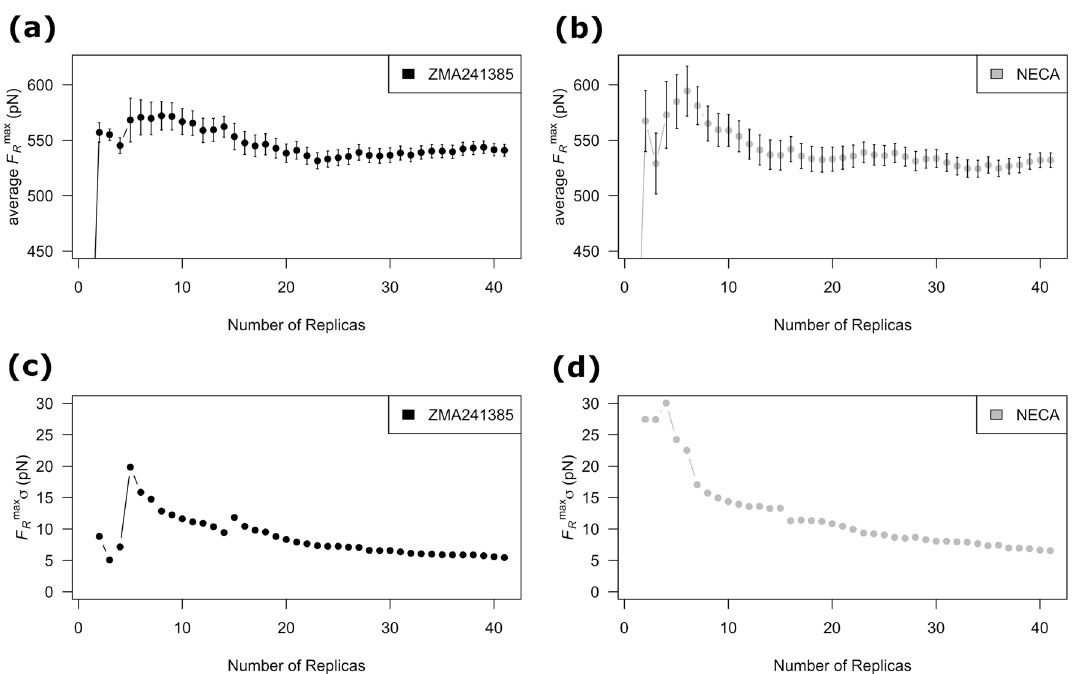
Figure 5. Variation of the bootstrap statistics, ( a ) and ( b ), the average maximum unbinding force ( F R max ) and, ( c ) and ( d ), standard deviation ( F R max σ) are shown as a function of number of replicas for the ligands ZMA241385 (black) and NECA (gray). The representative F R max values used for the bootstrapping analysis were extracted from the SMD simulations at a pulling velocity of 0.0010 nm/ps. The error bars for the, ( a ) and ( b ), average F R max values are the F R max σ